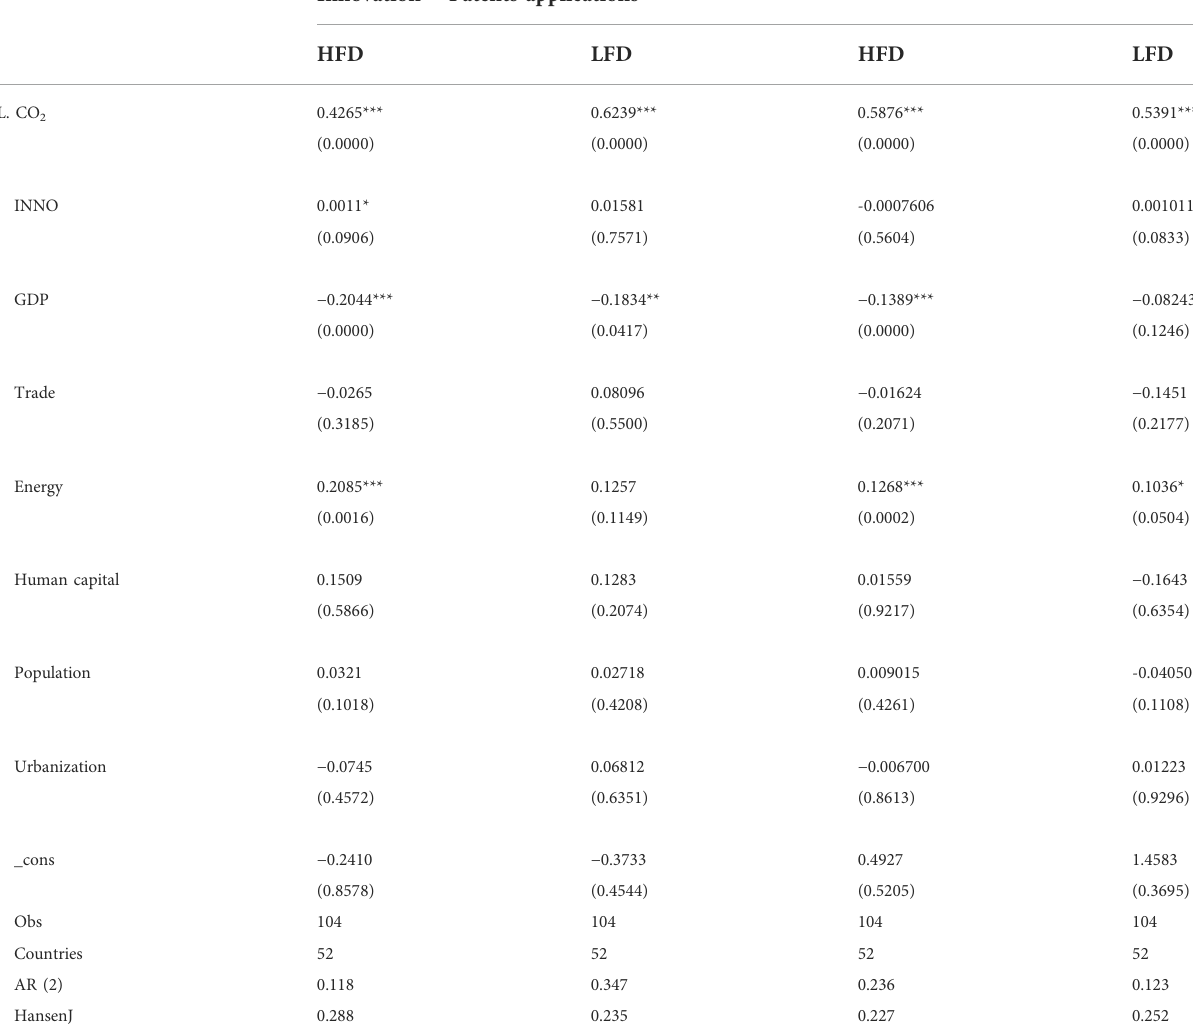
TABLE 4 Financial development, Innovation, and environment quality: 1990 – 2014. (Innovation = Patents